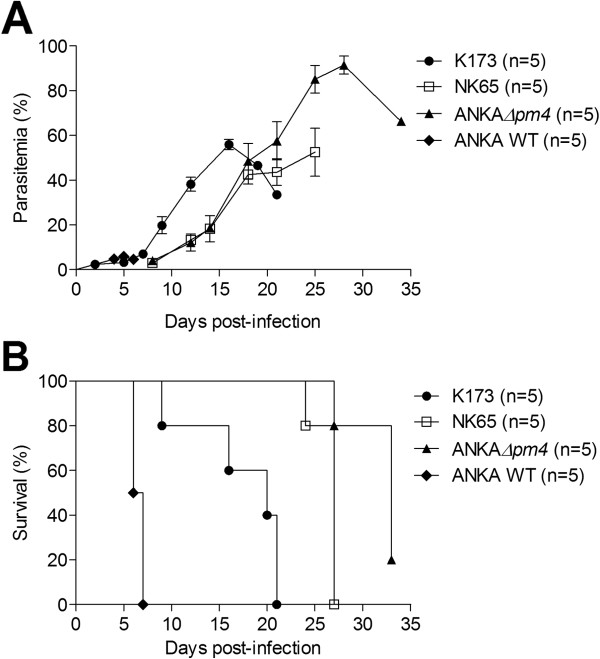
Susceptibility to infection of C57BL/6 mice. (A) Time-course parasitaemia and (B) survival of P. berghei K173, NK65 and ANKAΔpm4 in C57BL/6 non-pregnant mice. Animals were infected i.p. with 106 IE. Parasitaemia of DRAQ-5 labelled samples was followed by FACS. In (B) survival curves were compared using the Log-Rank (Mantel-Cox) test. Statistical significance results were p<0.01 when comparing K173 vs NK65 or ANKAΔpm4; p<0.05 when comparing NK65 to ANKAΔpm4.